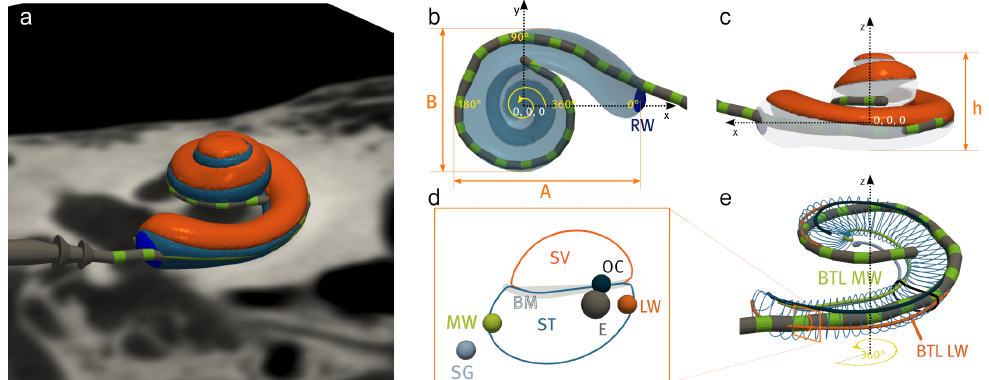
Figure 6. Cochlea and cochlear implant in the reference coordinate frame ( a ) and representation of different global ( b , c ) or cross-sectional metrics ( d , e ) that can be obtained using Nautilus. Examples include A, B, and the basal turn length (BTL) along various paths within the bony labyrinth (here, BTL LW and BTL MW are the 360-degree lengths covered while following the lateral wall (LW) or the modiolar wall (MW),